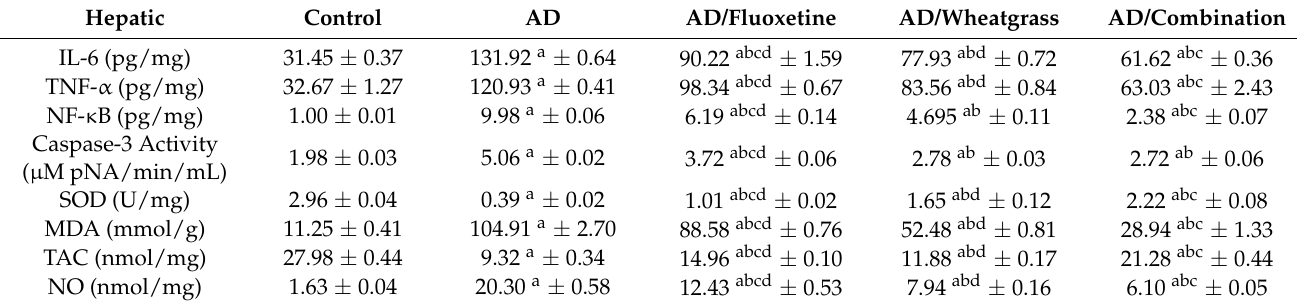
Table 3. Effect of fluoxetine, wheatgrass, or their combination on hepatic interleukin-6 (IL-6), tumor necrosis factor- α (TNF- α ), nuclear factor kappa B (NF- κ B), caspase-3 activity, malondialdehyde (MDA), nitric oxide (NO), superoxide dismutase (SOD), and total antioxidant capacity